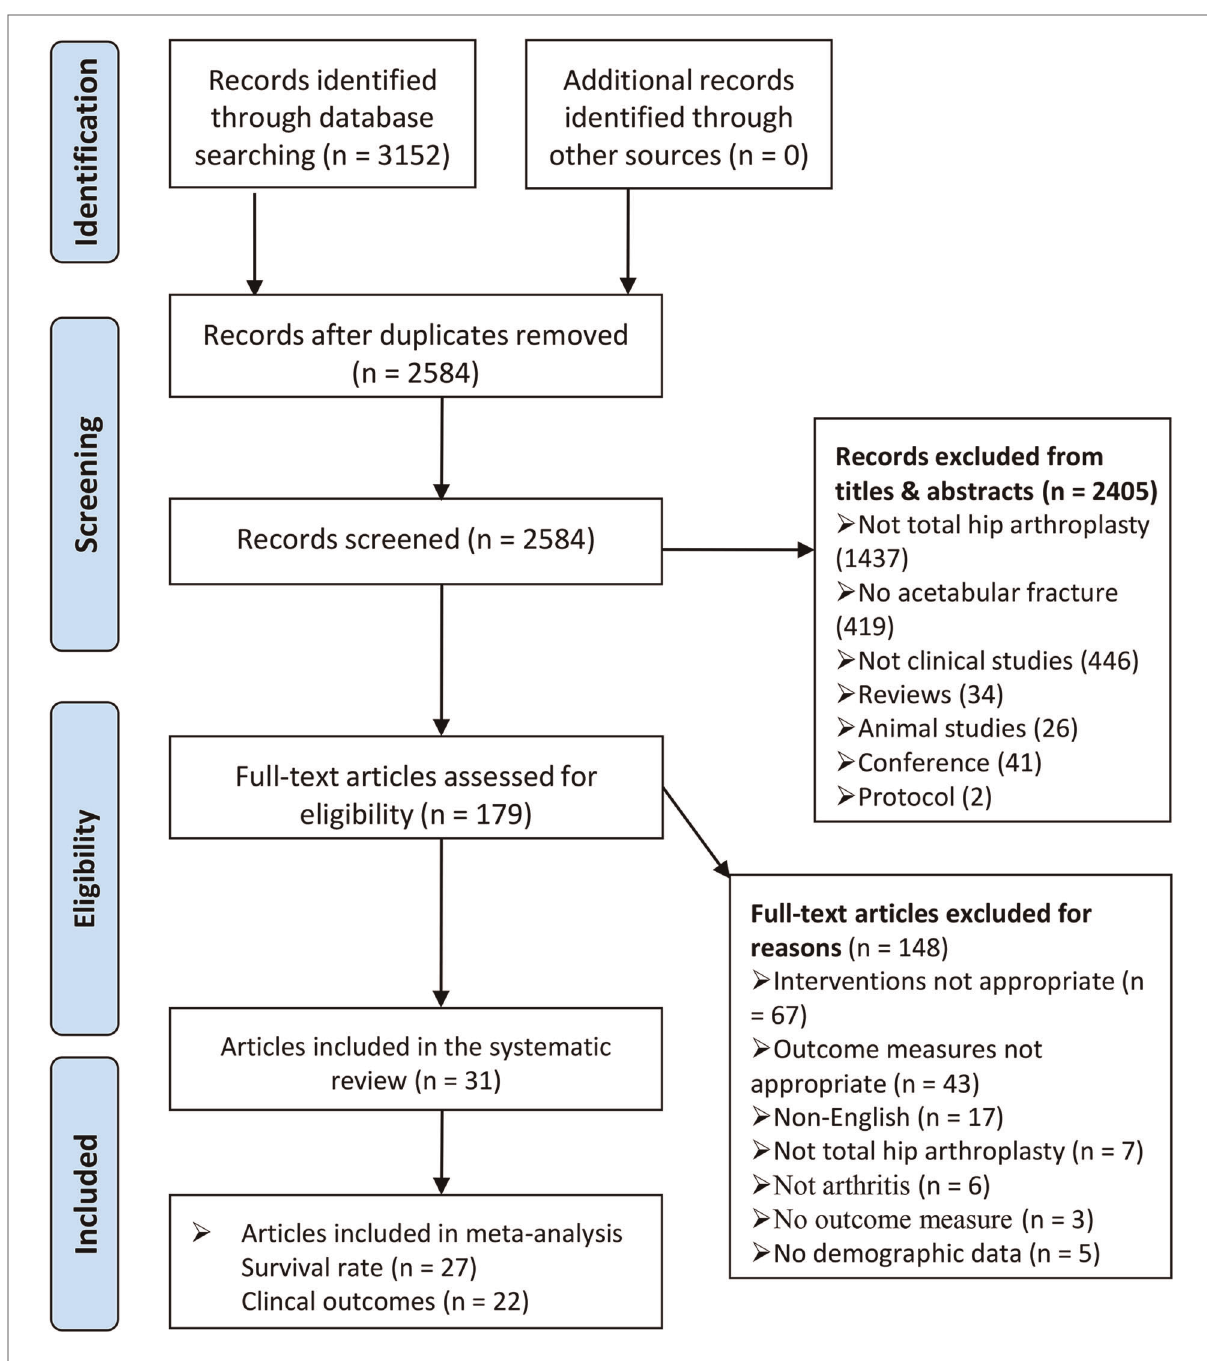
FIGURE 1 PRISMA fl ow